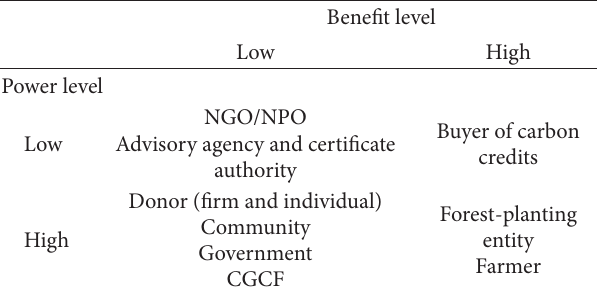
Table 2: Power-Benefit Matrix of stakeholders in CGCF voluntary forest carbon offset projects in